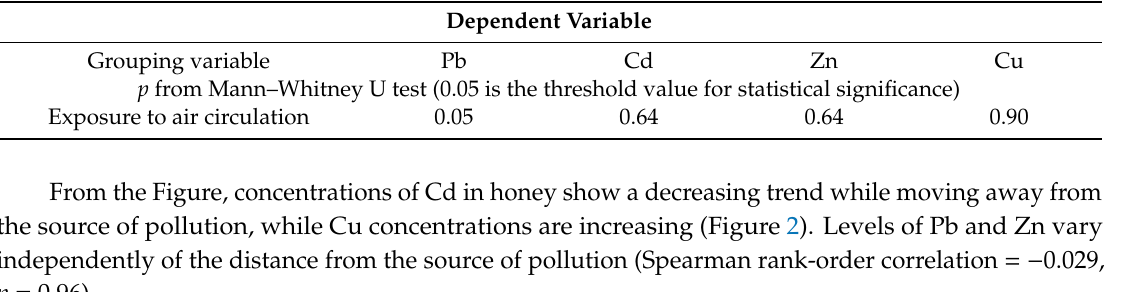
Table 6. Stratification of heavy metal concentrations in polyfloral honey.